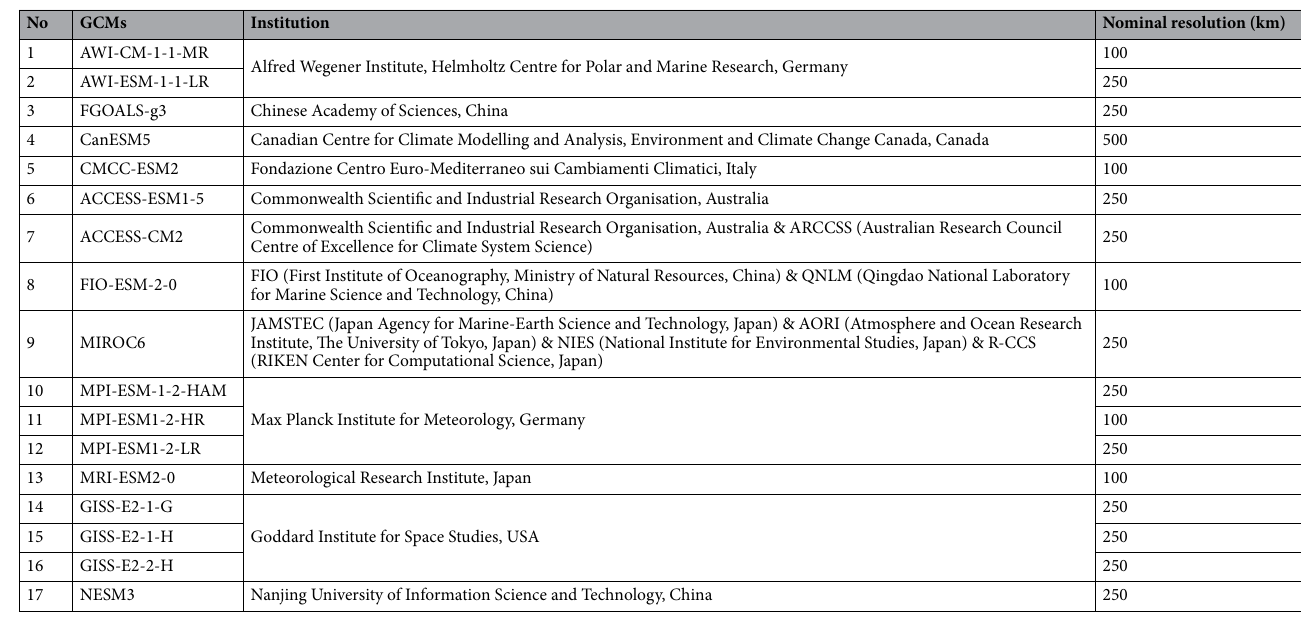
Table 1. Available CMIP6 GCMs sources and